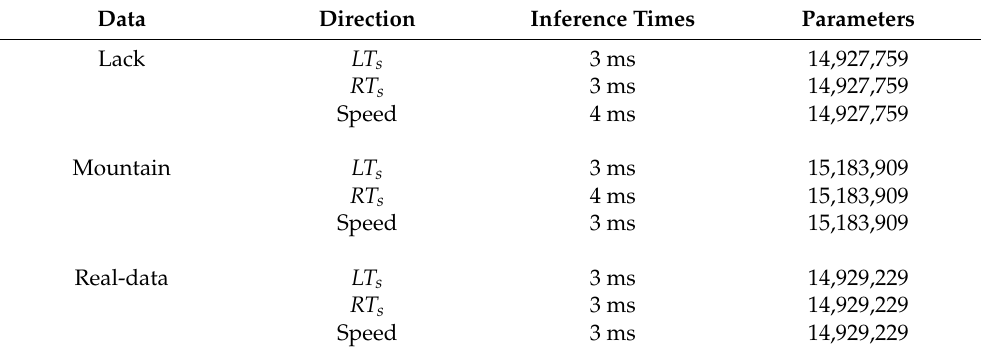
Table 4. Experimental results for the proposed model in terms of inference times and the total time for model execution.